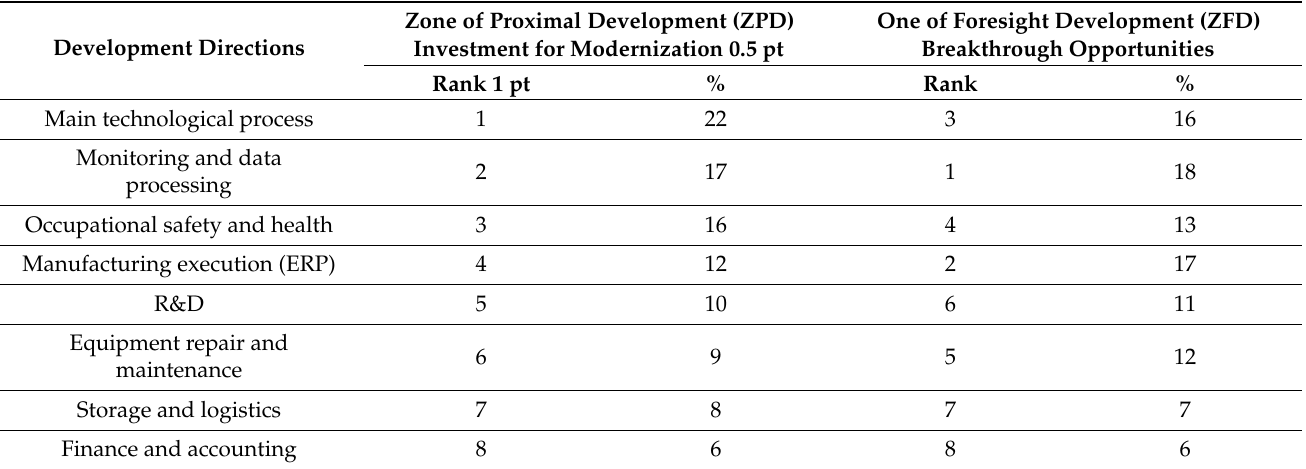
Table 2. Zones of perception of innovations in the formation of the foresight of the oil and gas industry of